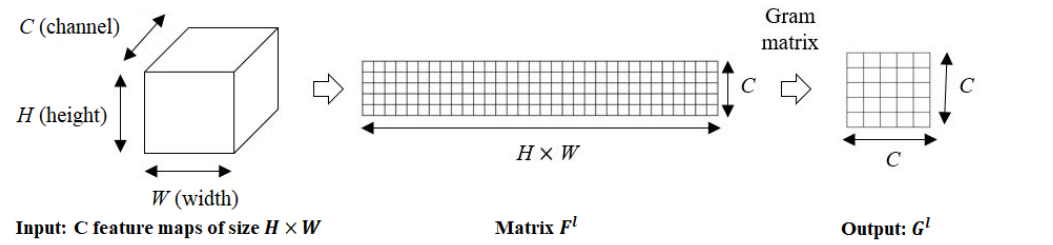
Figure 3. The process of Gram matrix computation.